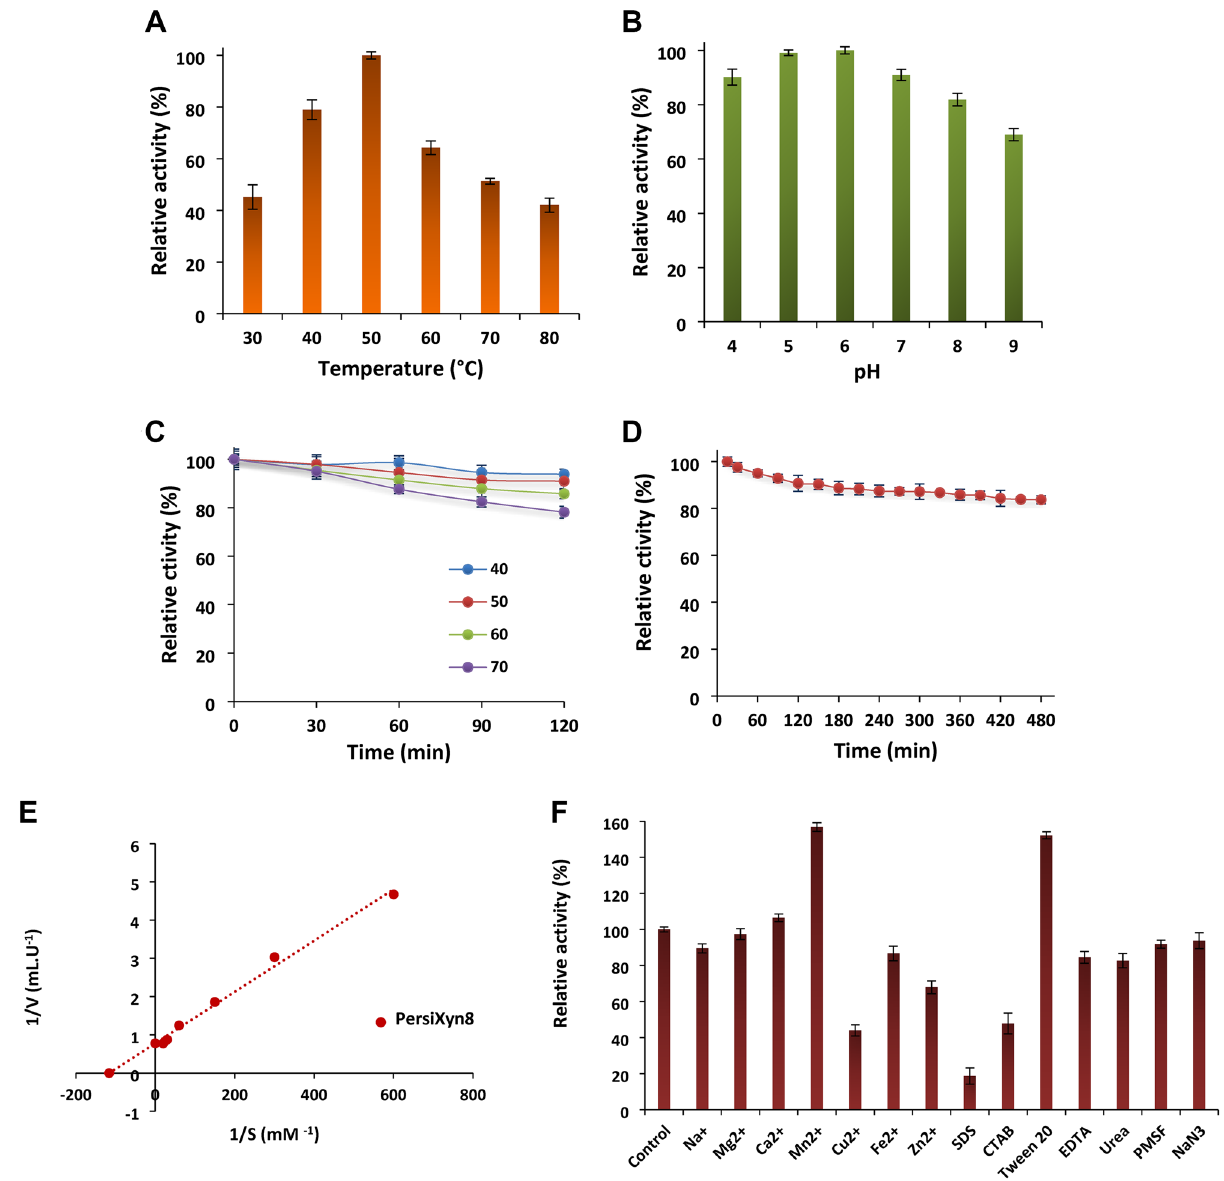
Figure 2. Biochemical characterization of the PersiXyn8. ( A ) Effect of temperature on the activity of the PersiXyn8 after incubation at 30 ℃ –80 ℃ for 20 min at pH 6.0. ( B ) Effect of pH on the activity of the PersiXyn8 after incubation in pH 4.0–9.0 for 20 min at 50 ℃ and using the beechwood xylan as substrate. ( C ) Effect of temperature on the stability of the PersiXyn8 after 120 min incubation at temperature from 40 ℃ to 70 ℃ . ( D ) Storage stability of the PersiXyn8 after 480 min incubation at 50 ℃ . ( E ) Lineweaver–Burk plot of the purified thermostable PersiXyn8. ( F ) Effect of metal ions, surfactants and inhibitors on the activity of PersiXyn8 after 30 min pre-incubation of enzyme and additives at room